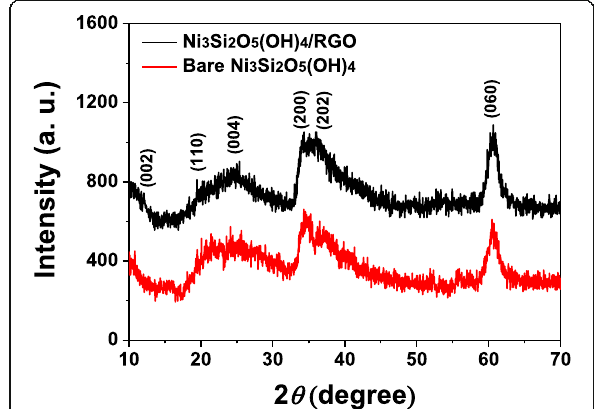
Fig. 3 XRD patterns of Ni 3 Si 2 O 5 (OH) 4 /RGO composite hollow microspheres ( black curve ) and bare Ni 3 Si 2 O 5 (OH) 4 hollow microspheres ( red curve )